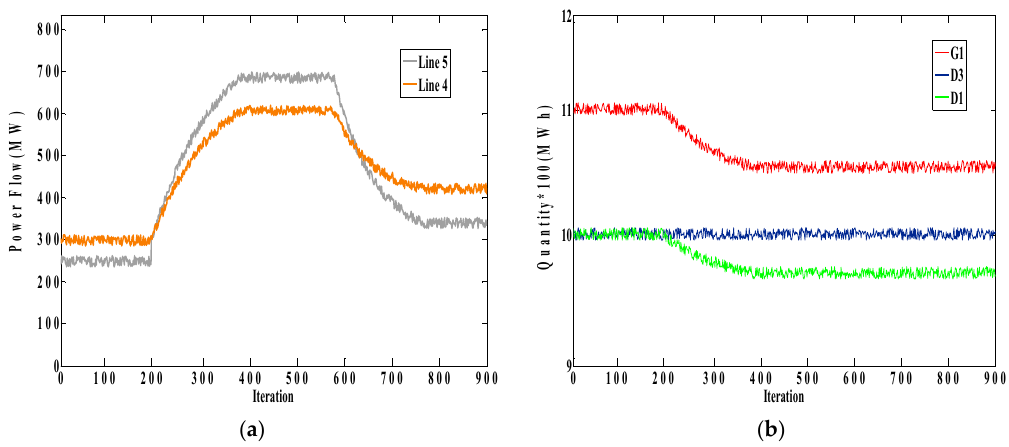
Figure 12. ( a ) Power flows of Lines 4 and 5 in Case A when the limit of Line 5 increases; ( b ) bidding quantity of G1, D1, and D3 in Case A.